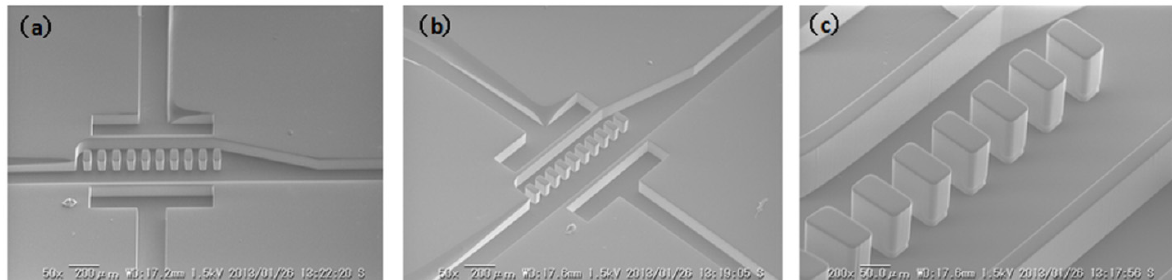
Figure 4. SEM Images of a complete Merging PDMS Device.